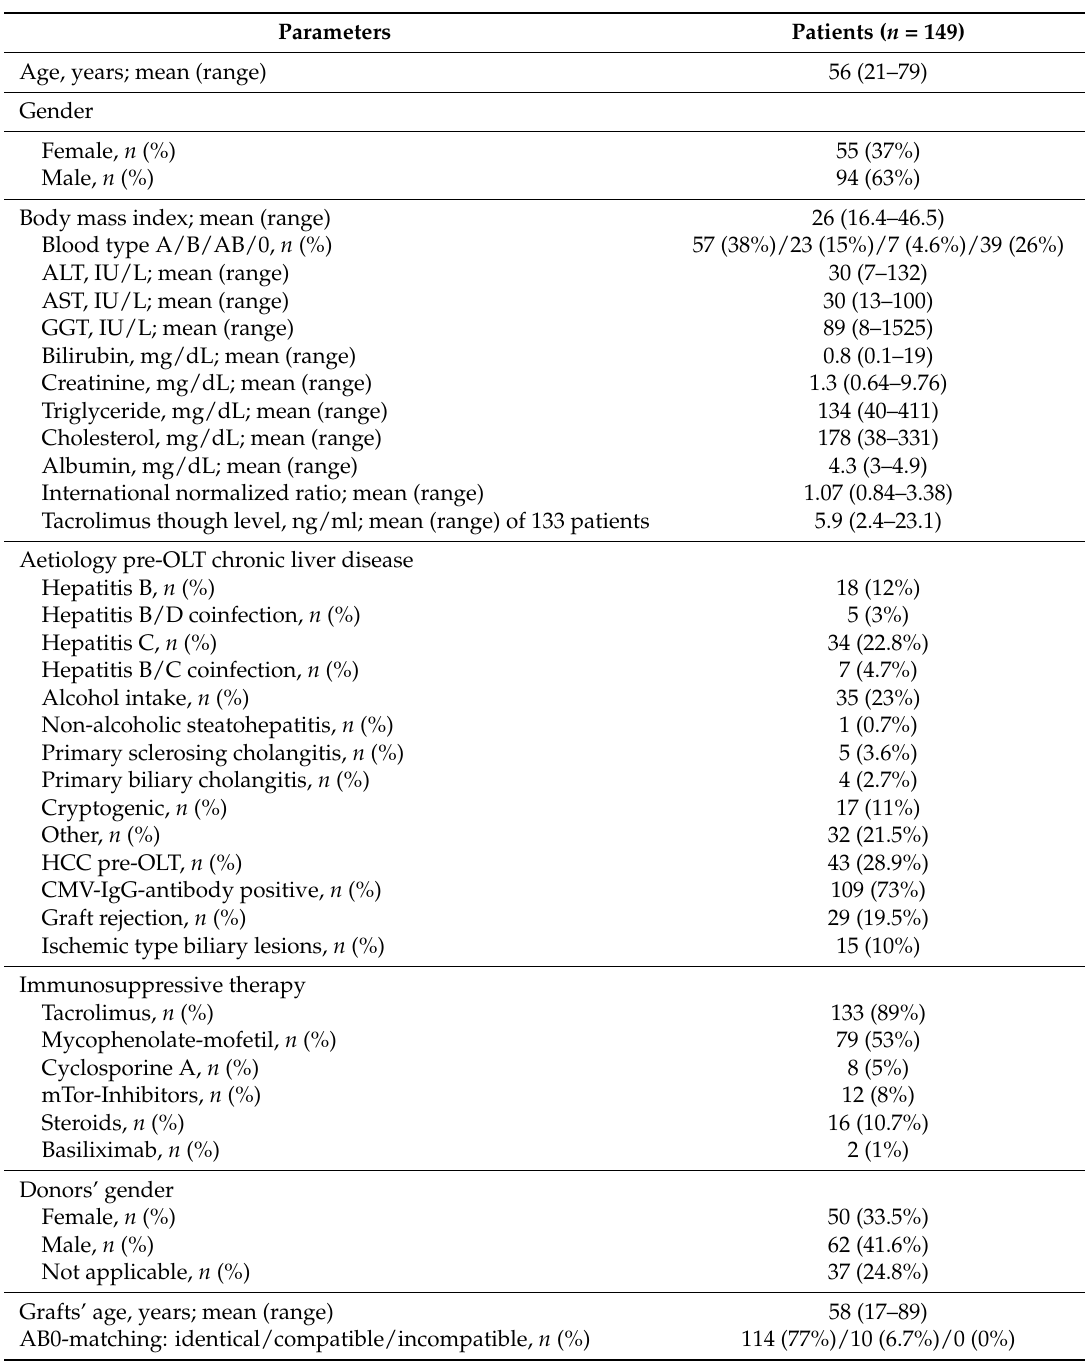
Table 1. Patients’